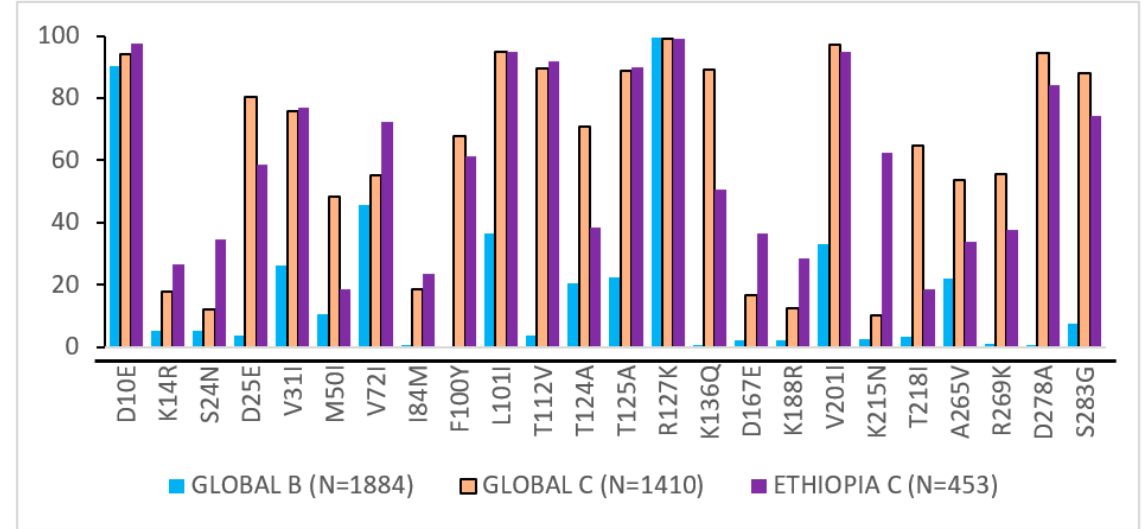
Figure 5. Prevalence of integrase highly polymorphic mutation in INSTI-naïve patients. The comparison was done using sequences downloaded from the Los Alamos National Library (LANL) database for subtype B ( n = 1884), HIV-1 subtype C ( n = 1410), and Ethiopian subtype C ( n = 453).